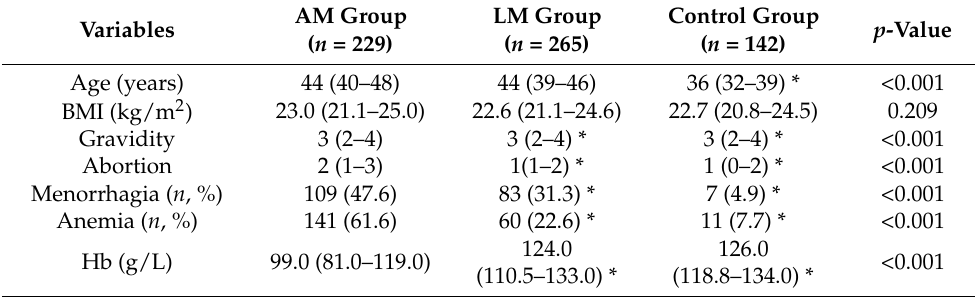
Table 1. Patients’